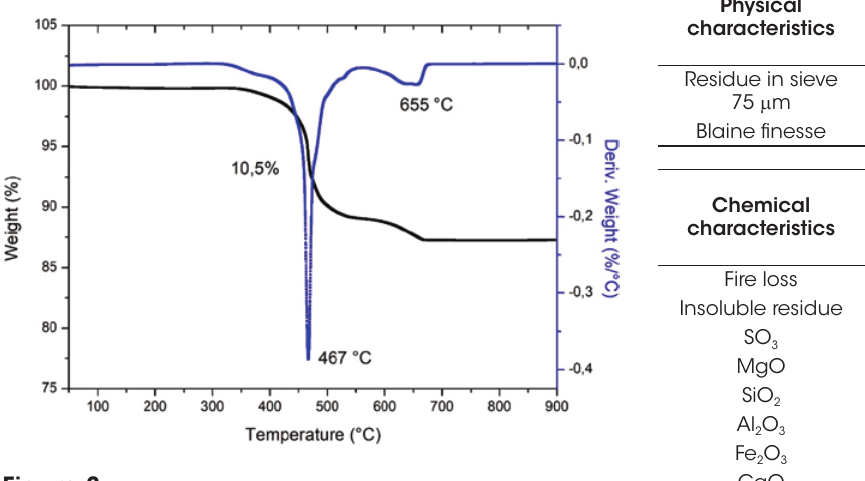
Thermo-gravimetrical analysis of the nanostructured